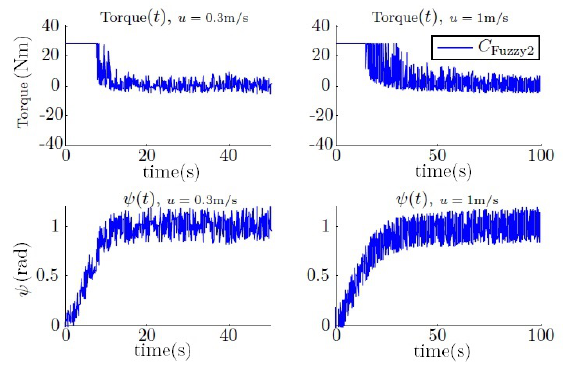
Figure 24. Step response of the yaw and torque using the fuzzy controller.